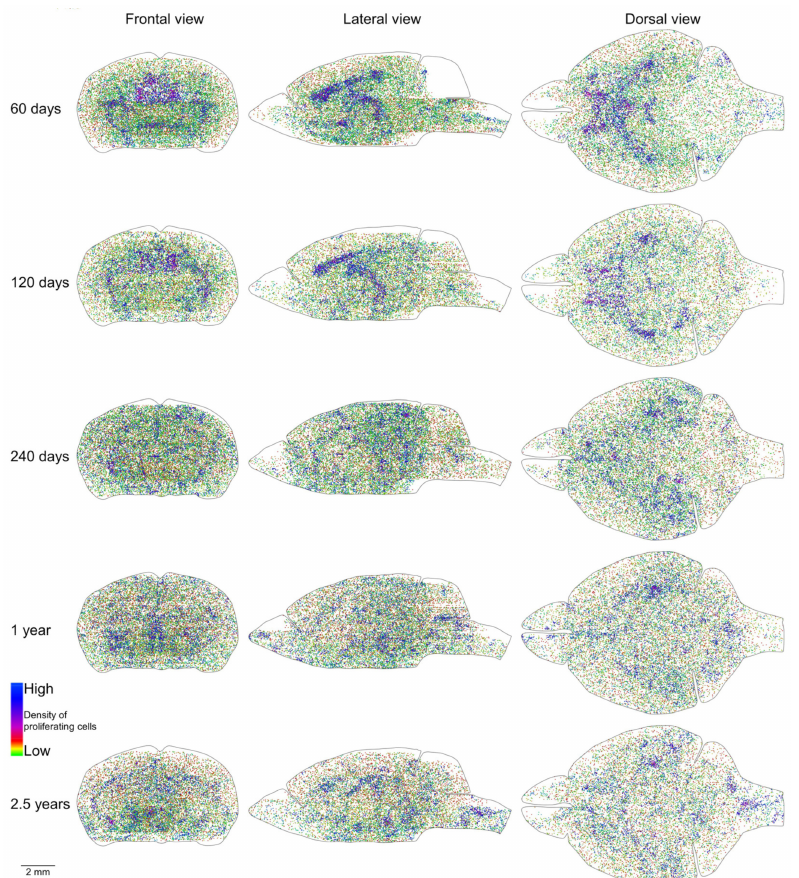
Figure 6. Distribution of proliferating cells outside of the MPZ and SGZ. Each EdU-labeled nucleus is shown as a colored dot with colors assigned according to the number of neighboring EdU-labeled nuclei located closer than 200 µ m to this nucleus. The color scale is shown on the bottom left. The brain shape is outlined with a black line. Frontal, lateral, and dorsal views of the brain are shown. Mouse age is shown on the left. The size scale is shown at the